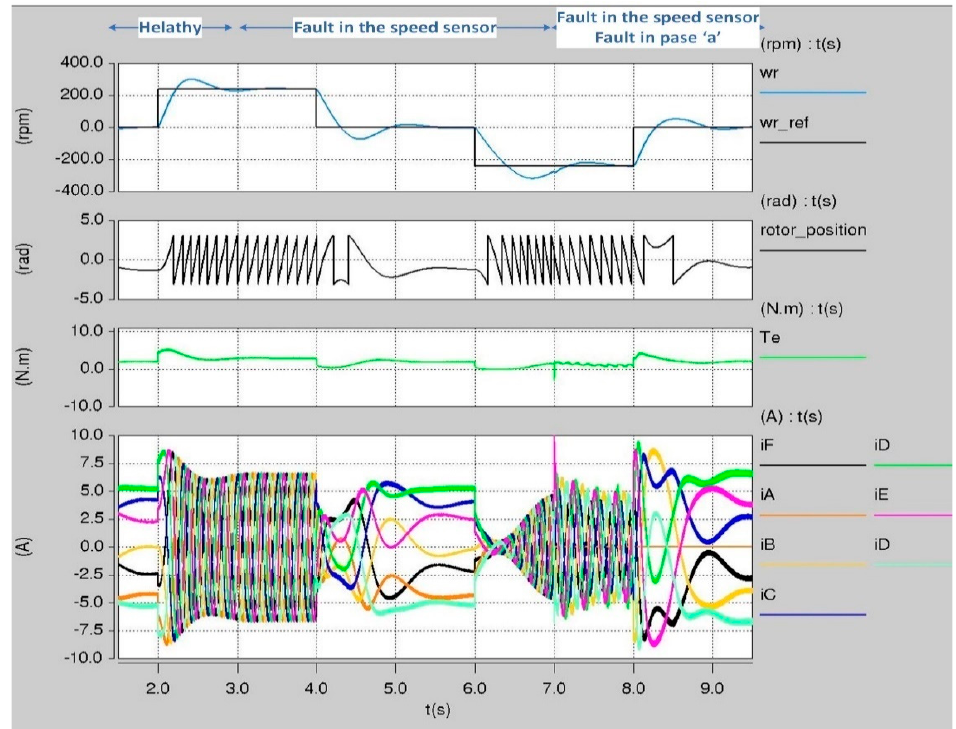
Figure 20. High speed steps of the seven ‐ phase motor drive post the failures in speed sensor and in phase ‘A’.